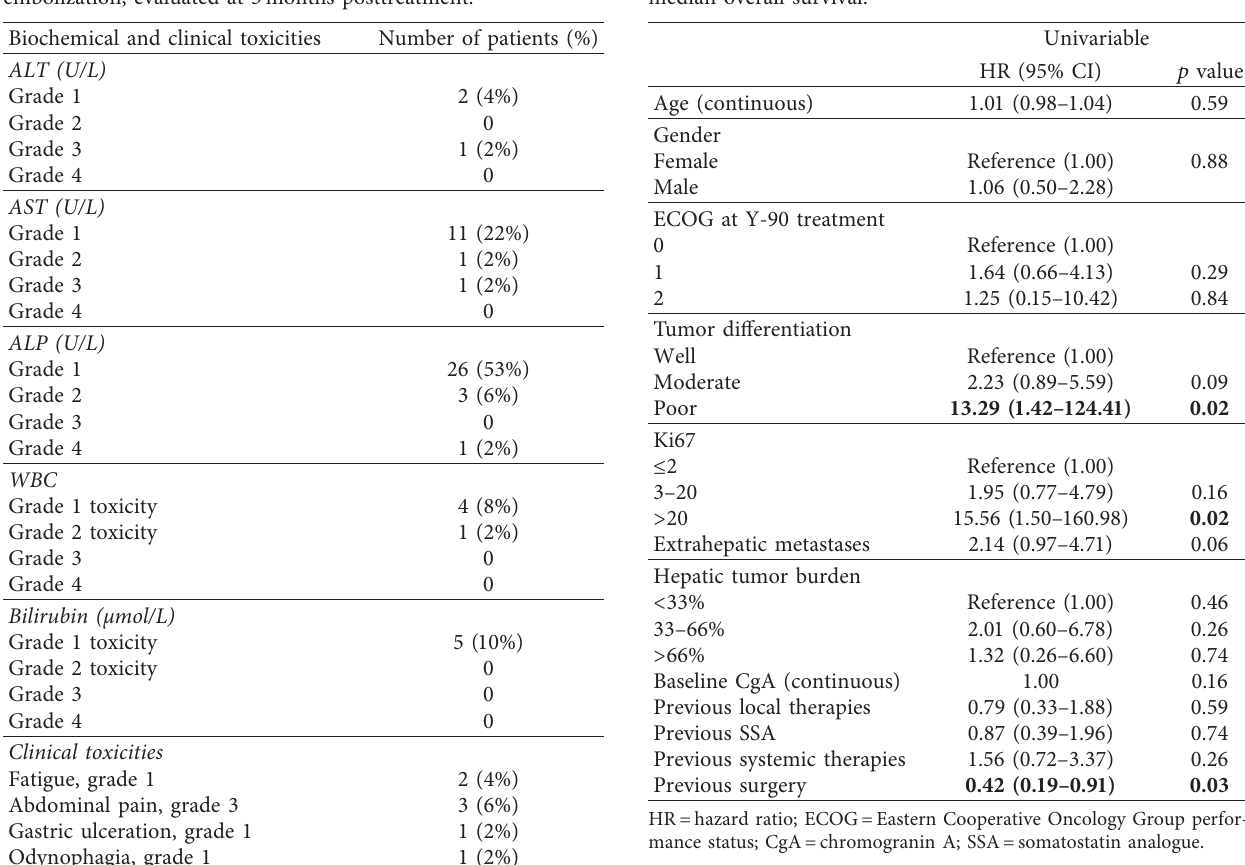
Table 2: Biochemical and clinical toxicities after Y-90 radio- embolization, evaluated at 3months posttreatment.